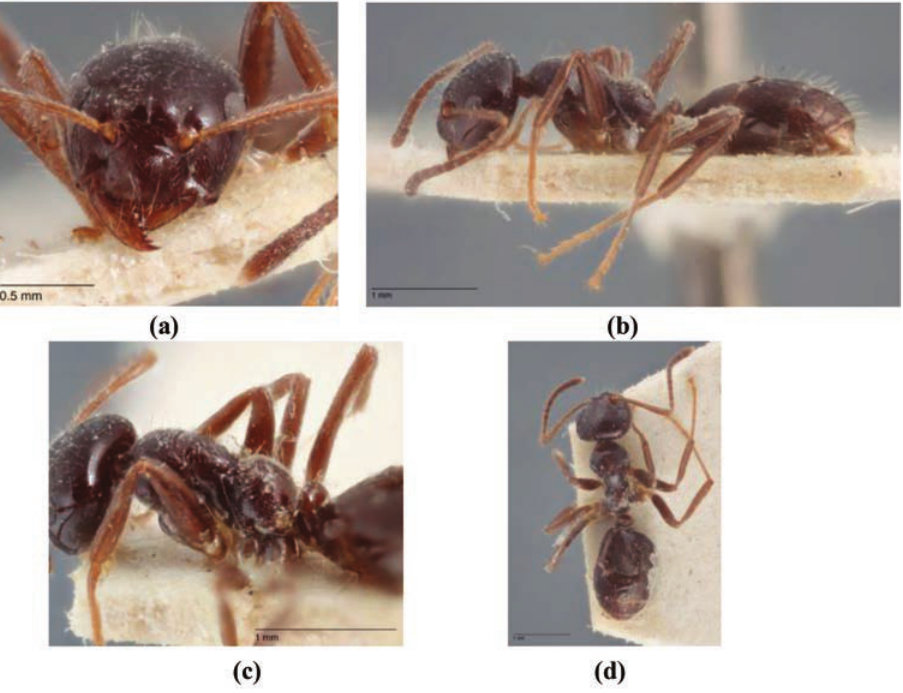
Figure 99. taxon scipio here transferred from Melophorus to Prolasius : sp. n.: SMNH minor worker holotype frons ( a ), profile ( b ), profile (enlargement) and dorsum ( d ). Low resolution scale bars: 1 mm ( b, c, d ); 0.5 mm ( a